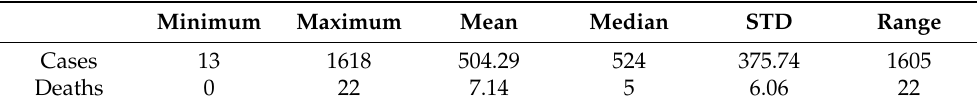
Table 1. Summary statistics of the number of COVID-positive cases and mortality rates in Kansas City from March to